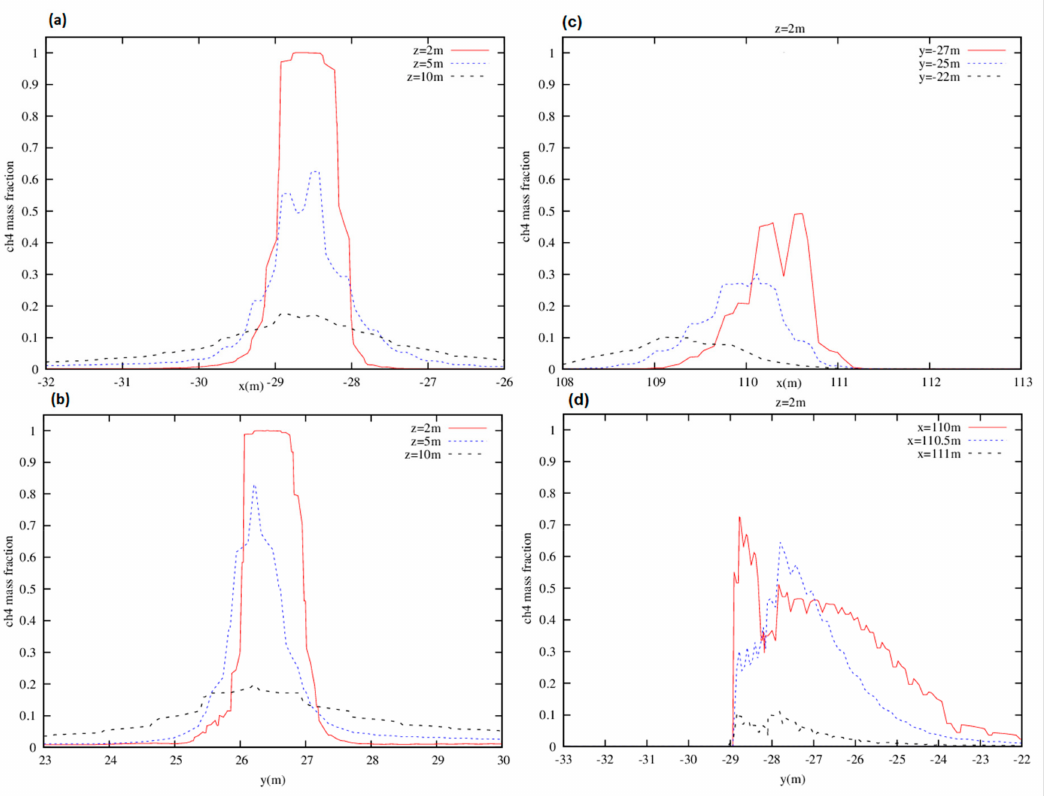
Figure 7. Methane (CH 4 ) mass fraction distribution in x and y directions: ( a , b ) For location 1 (at z = 2, 5, 10 m); and ( c , d ) for location 2 (at z = 2